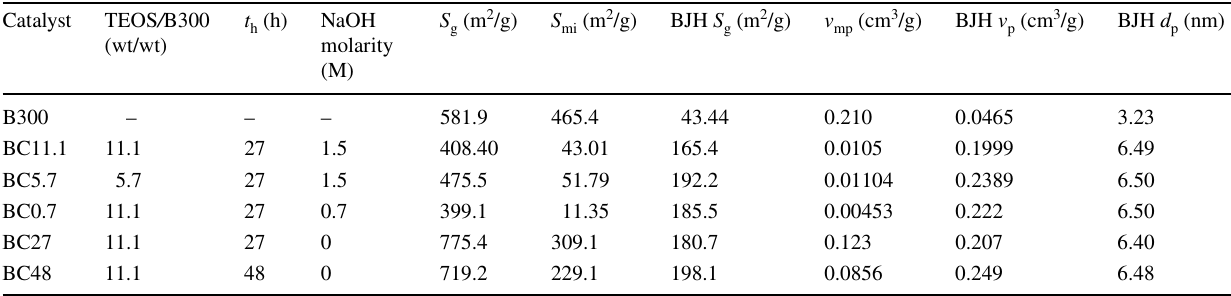
Table 1 Structural properties of the zeolite beta composite catalysts